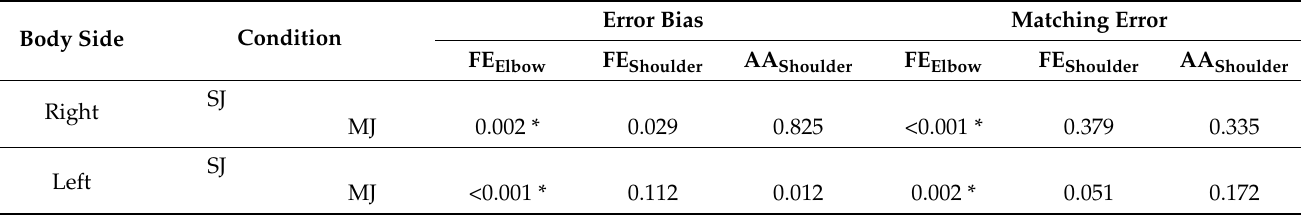
Table 2. Statistical p -values for the Error Bias and Matching Error between